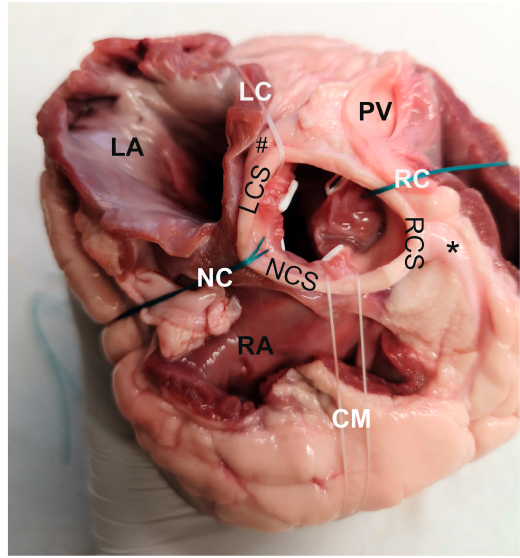
Figure 1. Example of a porcine heart from the top view with the aorta removed and four sutures in place. #, Left coronary artery; *, Right coronary artery; CM, commissural suture (here: between right and noncoronary leaflet); LA, left atrium (cut); LC, left coronary suture; LCS, left coronary sinus; NC, noncoronary suture; NCS, noncoronary sinus; PV, pulmonary valve (cut); RA, right atrium (cut); RC, right coronary suture; RCS, right coronary sinus.